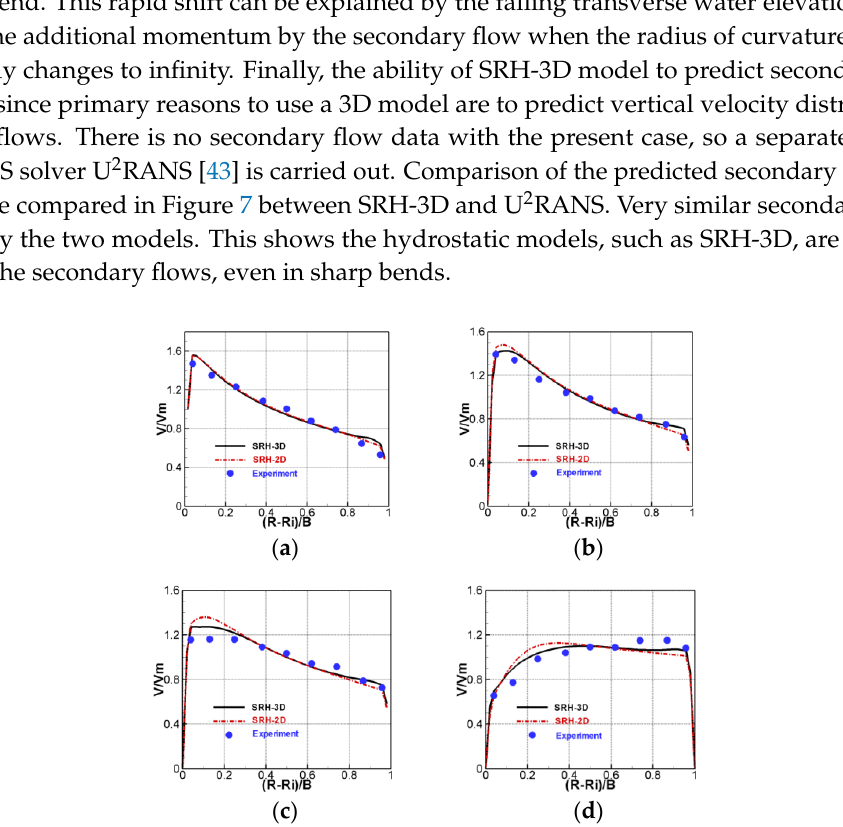
Figure 5. Model domain and the horizontal mixed mesh ( a ) and a comparison of the water depth along the inner and outer sidewall for the bend case ( b ).